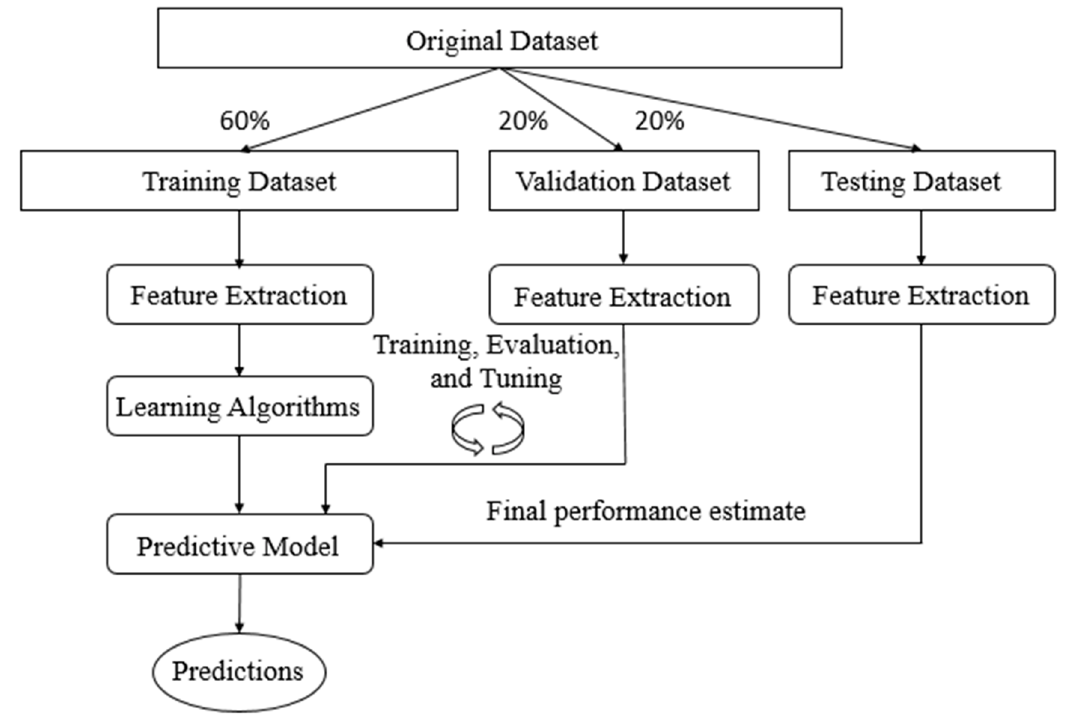
Figure 5. Charging Demand Prediction framework.